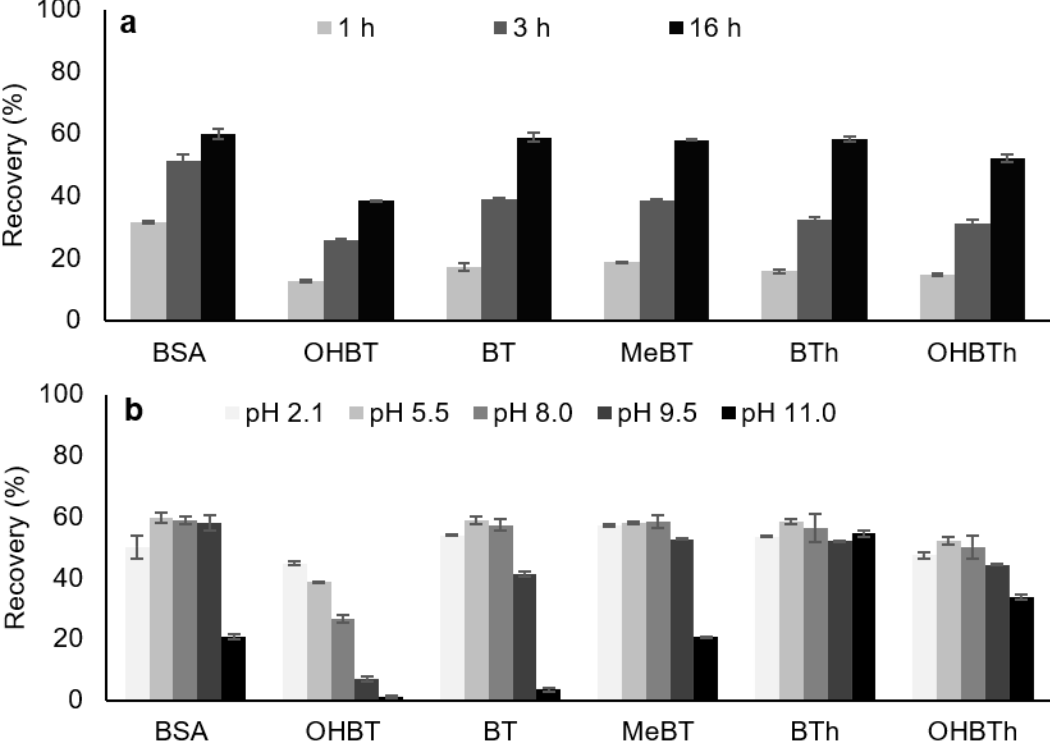
Figure 2. Effect of microextraction time ( a ) and matrix pH ( b ) on the microextraction recovery of BSA, OHBT, BT, MeBT, BTh, and OHBTh from aqueous media obtained by BA μ E(R, 12.5%/CN1, 87.5%)- μ LD/HPLC-DAD. The error bars represent the standard deviation of three replicates.